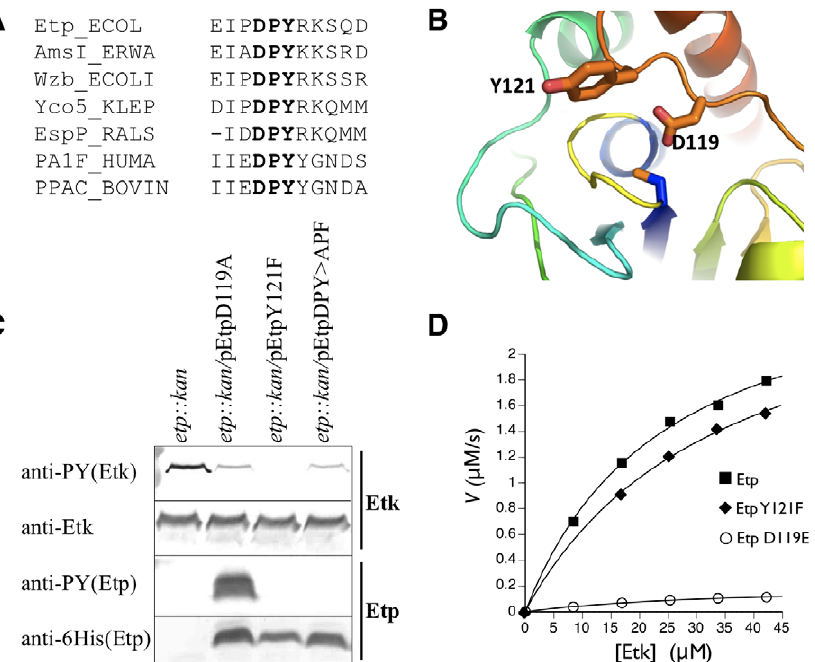
Figure 3. Identification of the phosphorylated Etp residue. (A) The region containing the DPY motif (in bold) of Etp is compared with the corresponding region of several members of the LMW-PTP family. They include AmsI of Erwinia amylovora , the E. coli -encoded Etp paralog Wzb, Yco5 of Klebsiella pneumoniae , EspP of Ralstonia solanacearum , the human PA1F protein, and the bovine PPAC protein encoded by the ACP1 gene. Numbering is according to the Etp sequence. (B) Homology model of the Etp structure in the absence of bound substrate based on the NMR structure of Wzb [19]. Side chains Tyr121 and Asp119 are shown in sticks. The phosphate binding loop (yellow) and catalytic cysteine C13 are in the center. (C) EPEC mutant D etp::kan was transformed with plasmids expressing different Etp mutants all of which had C-terminal 6His tags. Proteins were extracted from the different cultures and were subjected to Western blot analysis with anti-Etk, anti-6His and anti-PY antibodies as indicated. The corresponding strain is indicated above each of the lanes. (D) In vitro kinetics of Etp and variants with phosphorylated MBP-Etk as substrate. The graph plots the rate of inorganic phosphate produced versus substrate concentration for Etp, EtpY121F, and EtpD119E. Kinetic constants are in Table 1.